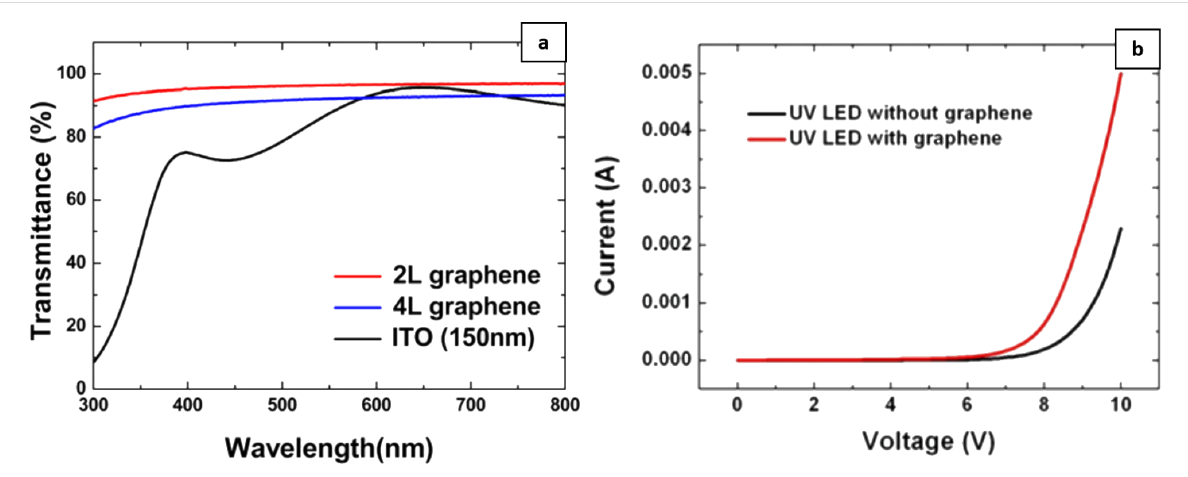
Figure 1: (a) Transmittance from 300–800 nm of ITO (150 nm), two-layer (2L) and four-layer (4L) graphene and (b) the I – V characteristics of UV LED with and without few-layer graphene-based conductive electrodes. Figure 1a and Figure 1b were adapted from [39], with the permission of AIP Publishing. This content is not subject to CC BY